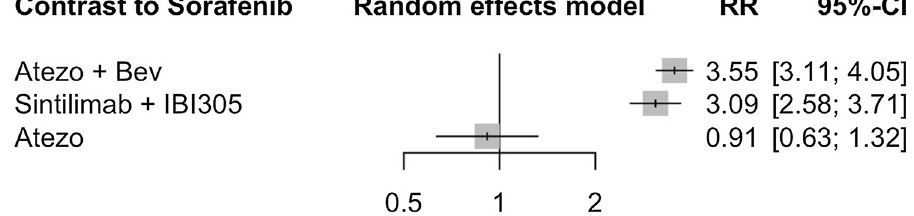
Fig. 11 Forest plot for DCR compared to